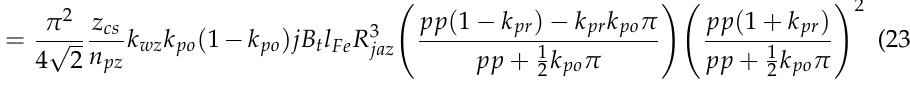
Figure 8. Cogging motor configuration with 12 pole pairs . Figure 9. Electromagnetic torque and its average value for a one segment of cogging motor with eight and 12 pole pairs. 0